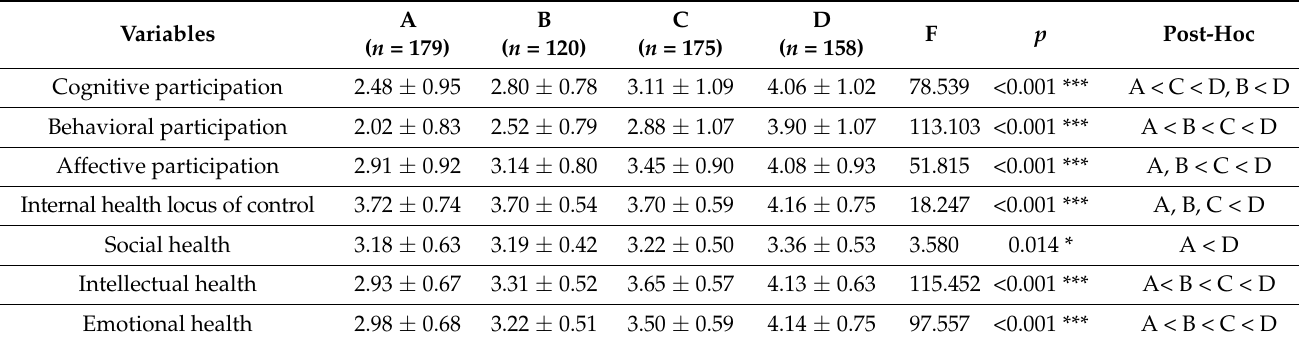
Table 8. Differences among variables by sports participation time.